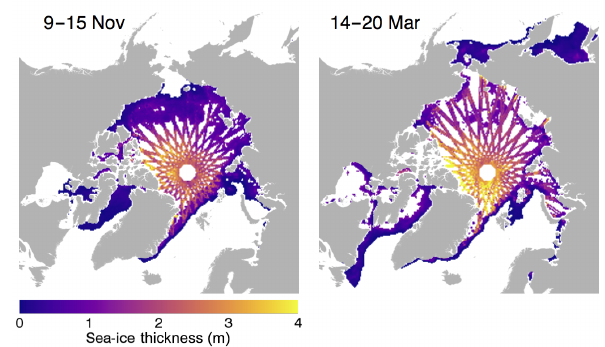
Figure 3. (a) Numbers of valid 25km grid cells each month from November 2015 to April 2016. Here, “valid” grid cells are grid cells that contain a valid thickness estimate. (b) Spatial distribution of valid weekly thickness retrievals by CryoSat-2 and SMOS.